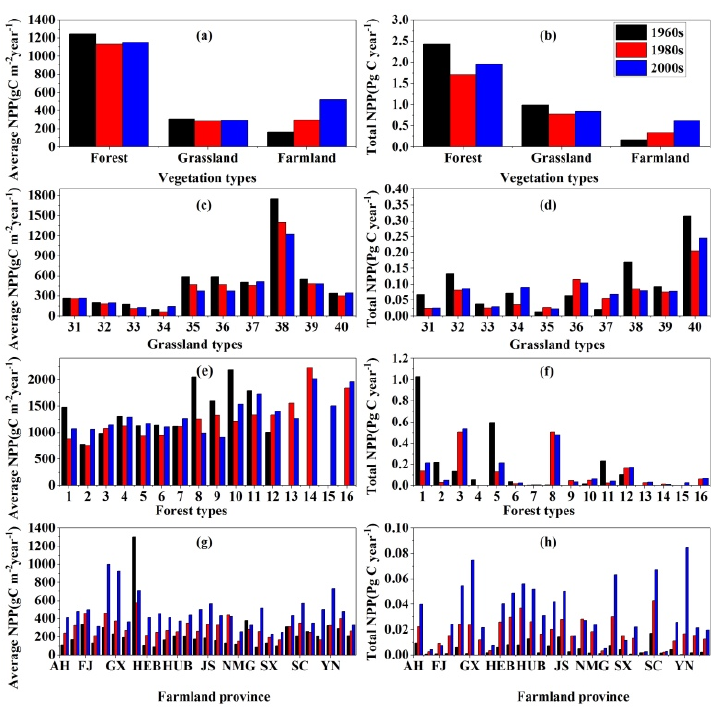
Figure 5. NPP Changes of different vegetation types from the 1960s to 2000s: ( a ) average vegetation NPP; ( b ) total vegetation NPP; ( c ) average NPP in different forest types; ( d ) total NPP in different forest types; ( e ) average NPP in different grassland types; ( f ) total NPP in different grassland types; ( g ) average NPP in different farmland provinces; and ( h ) total NPP in different farmland provinces. The meaning of the id numbers are listed for the forest (1–16) (Table S1), grassland (31–40) (Table S1), and farmland (Table S5), respectively.